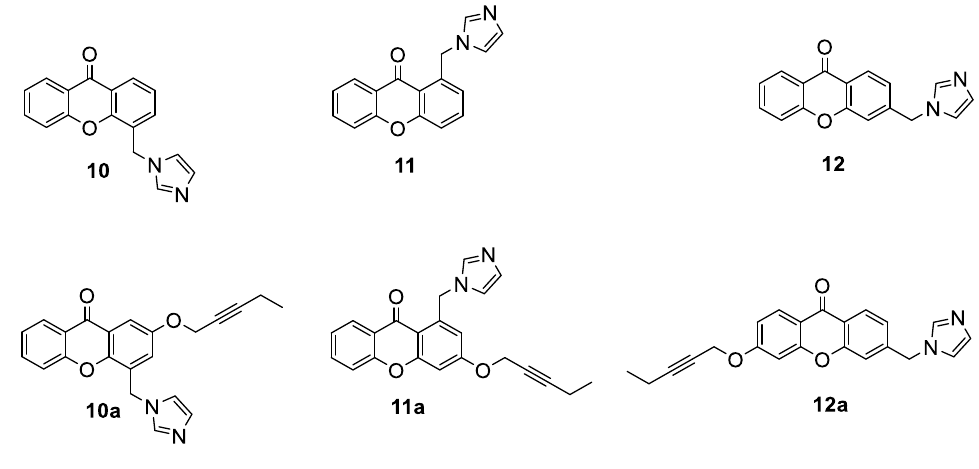
Figure 10. Design of potential nonsteroidal dual-acting AIs.